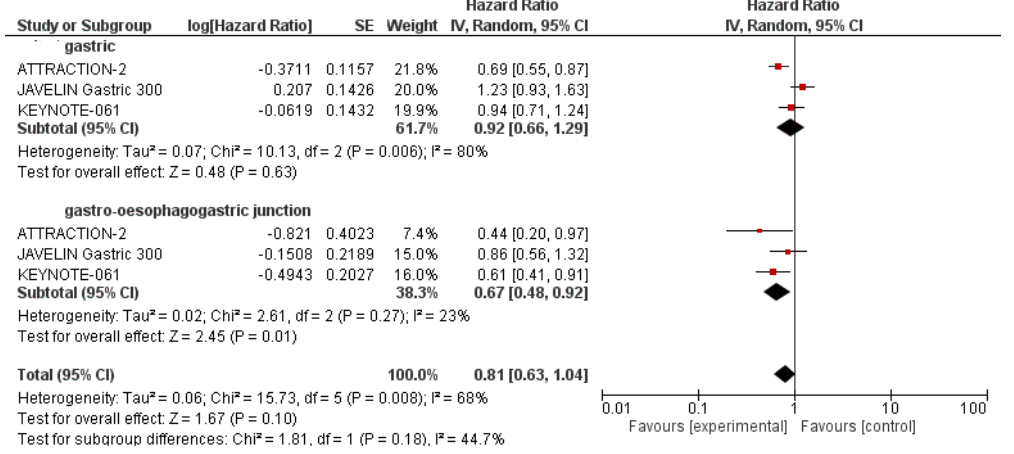
Figure 3. Subgroup analysis for overall survival of immune checkpoint inhibitors compared to the control arm in patients with gastro-oesophagogastric junction and gastric tumour location. Table 4. Subgroup analysis of immune checkpoint inhibitors (ICIs) compared to the control arm in gastric cancer.